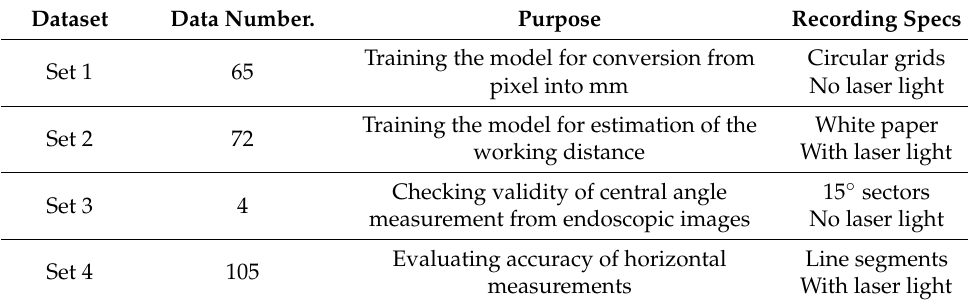
Table 1. Summary of the datasets used in this